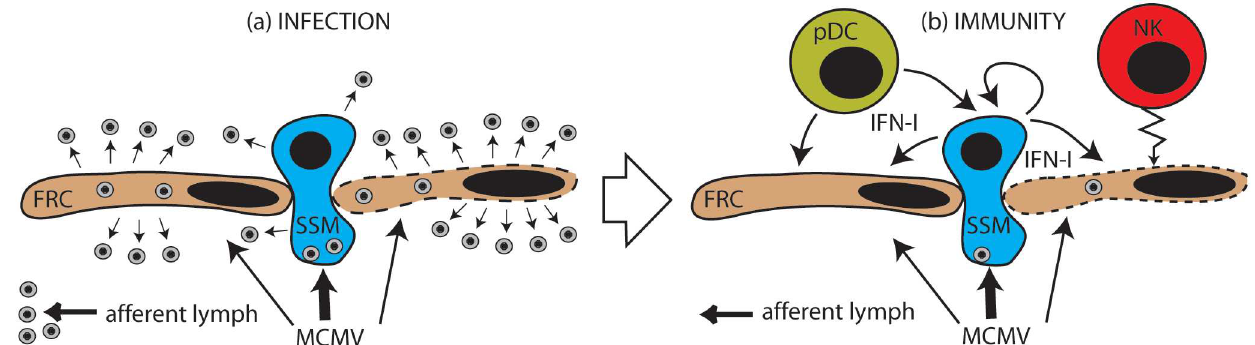
Fig 12. Schematic representation of MCMV escapefrom the LN subcapsular sinus. Most virions in the afferent lymph are captured by SSM, but some infect FRC. In the absence of IFN-I (a) , FRC infection is highly productive, SSM infectionrather less so. Virions are releasedinto the LN to infect new FRC and myeloidcells, and also back into the lymph flow, whencethey can reach the blood. To counter this (b) , IFN-I from SSM capturingvirions inhibits infectionin both SSM and FRC. pDC also produceIFN-I. They may receiveinfected cell debris and cytokines via the FRC conduits. Inflammatory mediatorsalso recruit NK cells to kill infected FRC. Thus MCMV propagationis largelysuppressed.